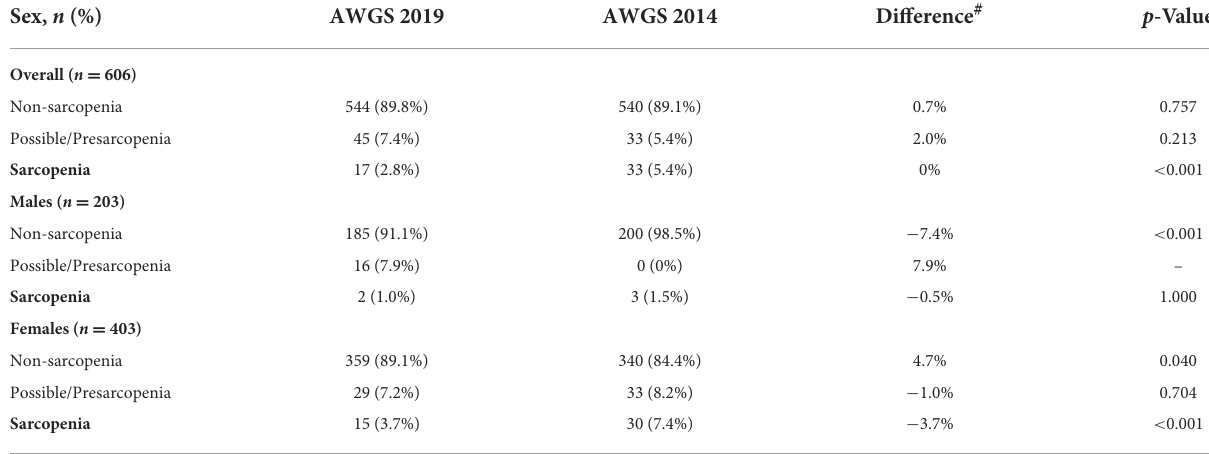
TABLE 2 Prevalence and difference of non-sarcopenia, pre/possible sarcopenia, and sarcopenia in Taiwanese community-dwelling adults using the cut-of values from the 2014 and 2019 Asian Working Group for Sarcopenia (AWGS) definition, stratified by sex. Sex, n (%)